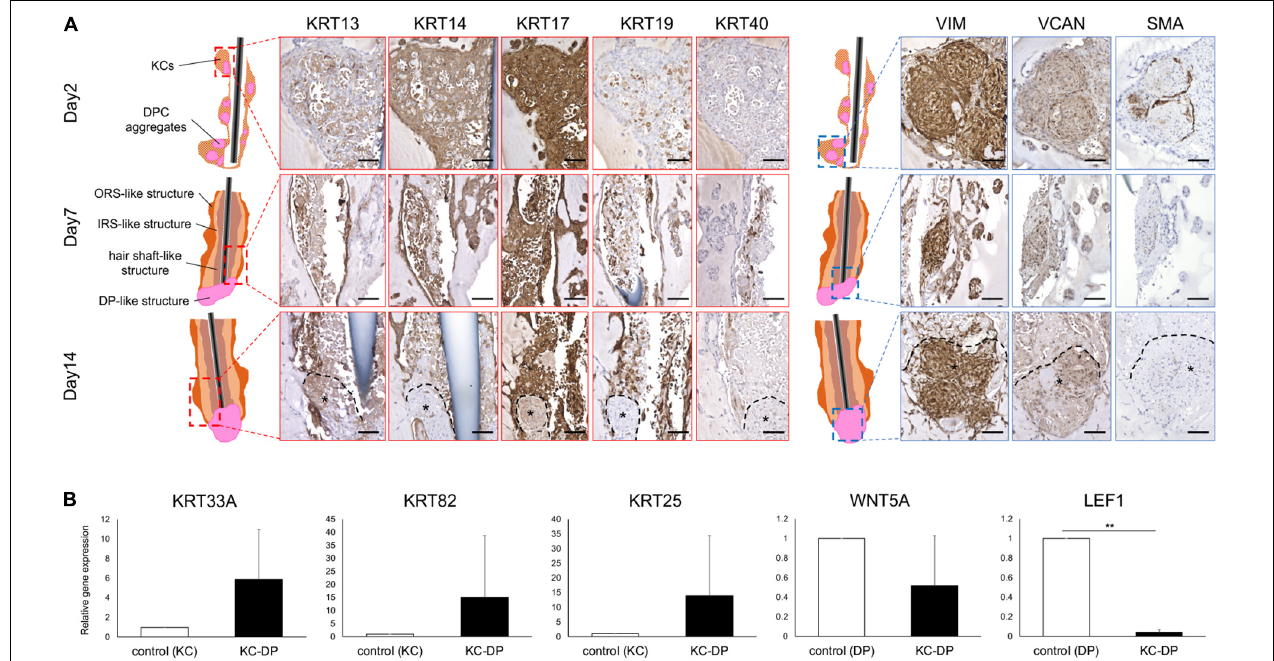
FIGURE 2 | Immunohistochemical and gene expression analysis of HF marker expression in KC-DP construct. (A) Time course immunohistochemical analyses revealed that the constructs regenerated with keratinocytes and dermal papilla cells (KC-DP) gradually recapitulated hair follicle (HF) marker expression patterns resembling those in human HF (see Supplementary Figure S6 ) during 2-week culture. KRT13 is expressed in the inner portion, while KRT14 is detected in the outer portion. KRT17 is diffusedly expressed in the main body, while KRT19 gradually became detectable in the inner and outermost portion. Linear immunoreactivity of KRT40 extended from DP. VIM, VCAN, and SMA were detected in DP. *: DP aggregates. (B) The expression levels of HF-related genes in KC-DP constructs (Mean ± SEM; n = 5, triplicate for each experimentation; ** p < 0.01, Wilcoxon signed-rank test). DP, dermal papilla; DPC, dermal papilla cells; KC,